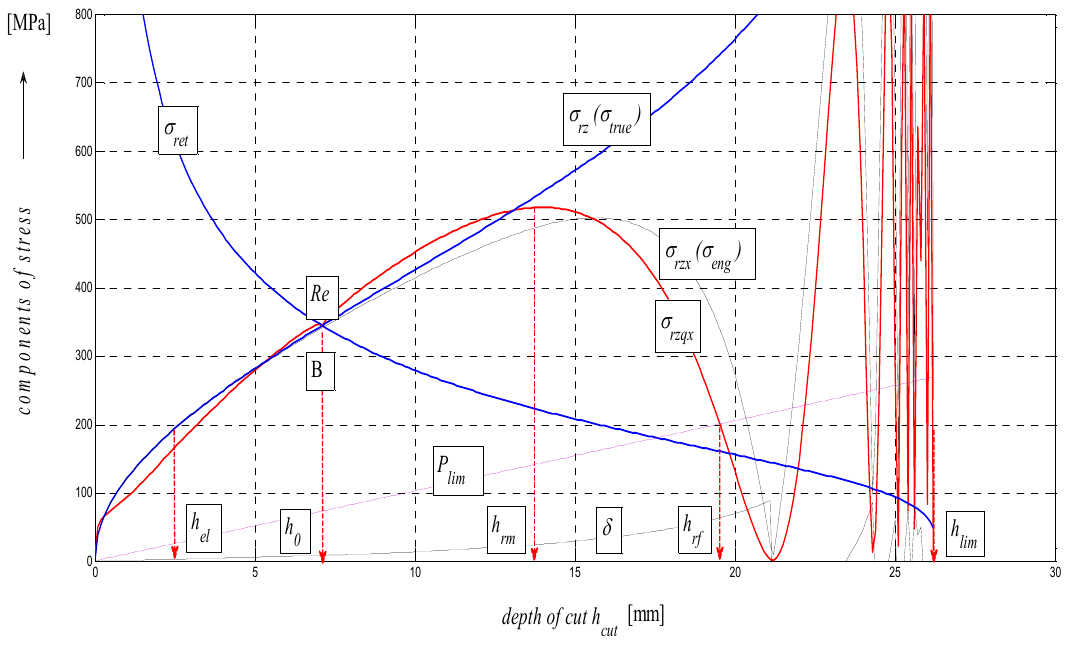
Figure 6. Components of steel AISI 304 material, E mat = 195 GPa.